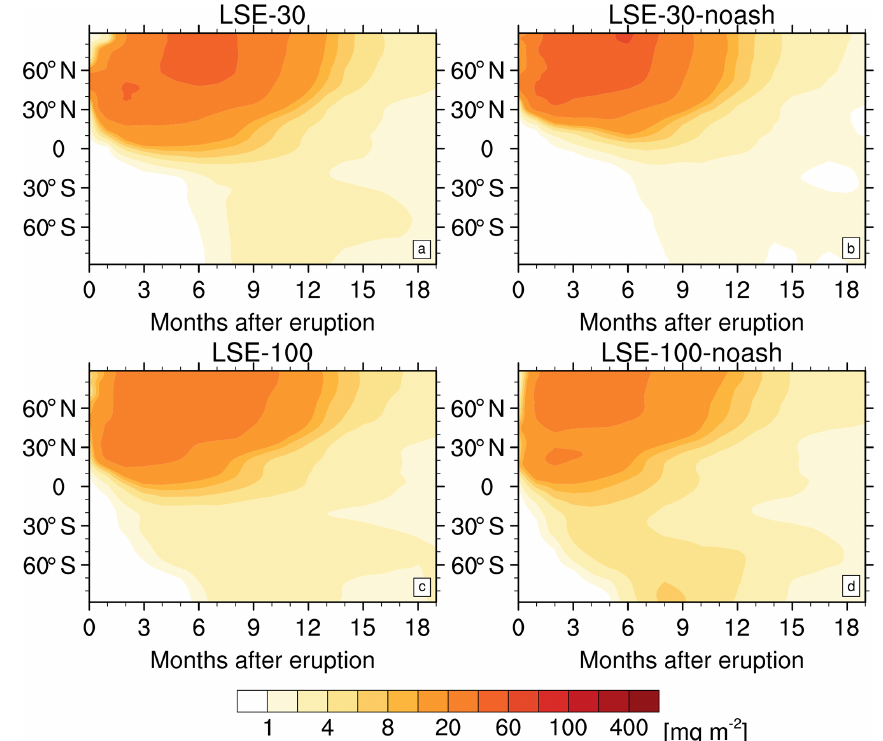
Figure 7. Hovmøller diagram of zonally averaged sulfur burden [mg(S)m − 2 ] for an assumed LSE-like eruption over a period of 1.5 years after the first eruption phase. On the left are simulations with injection of fine ash: (a) LSE-30 (c) LSE-100. On the right are the corresponding simulations without the injection of fine ash: (b) LSE-30-noash and (d) LSE-100-noash.